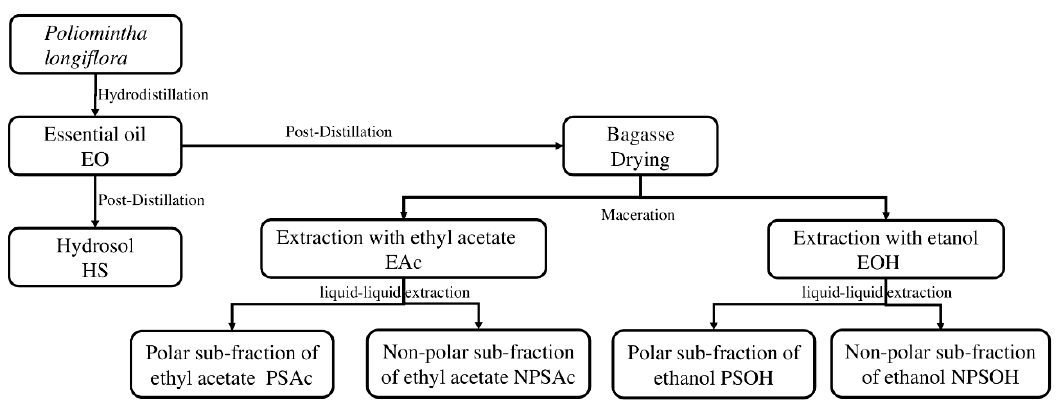
Figure 2. Flow diagram of P. longiflora essential oil (EO), hydrosol and extracts from the waste solid residues preparation procedure